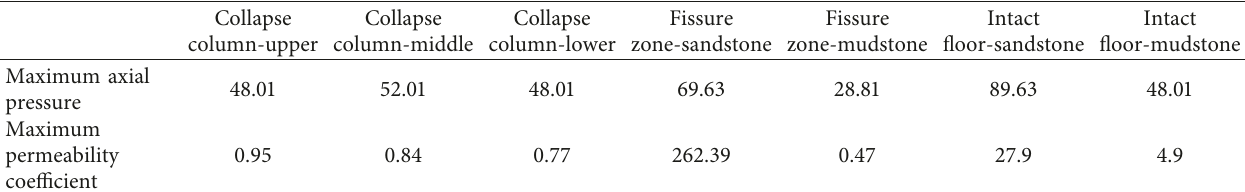
Table 2: Maximum strength and permeability coefficient of each sample.